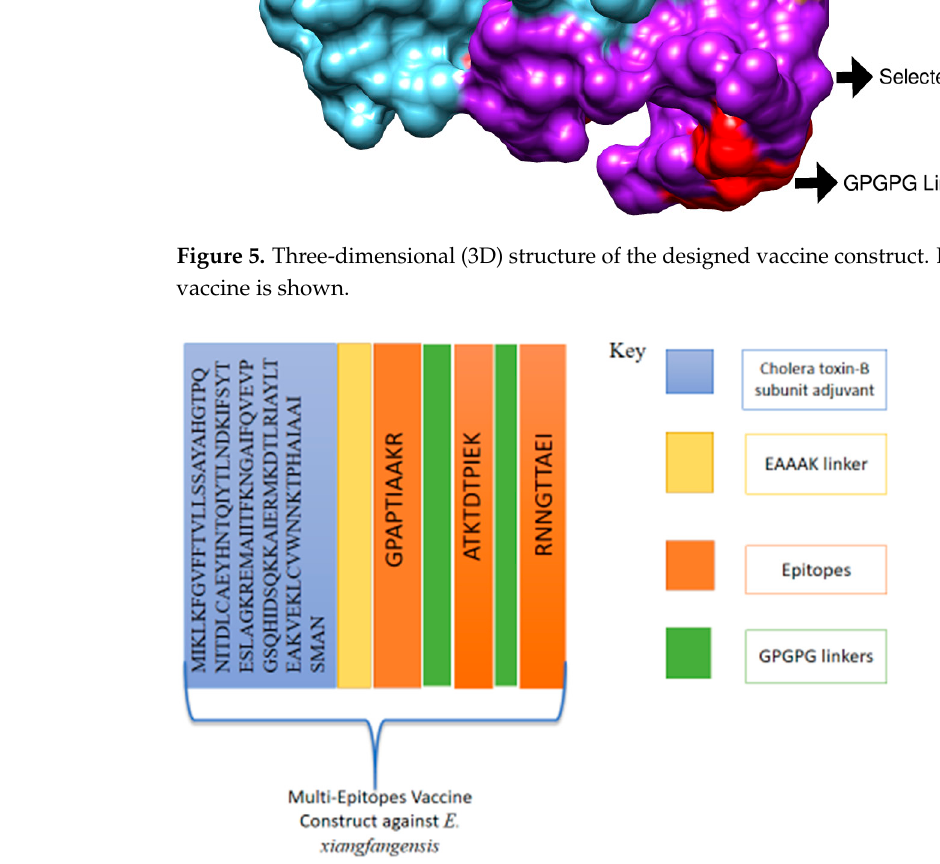
Figure 6. Schematic representation of multi-epitope vaccine construct for E. xiangfangensis.